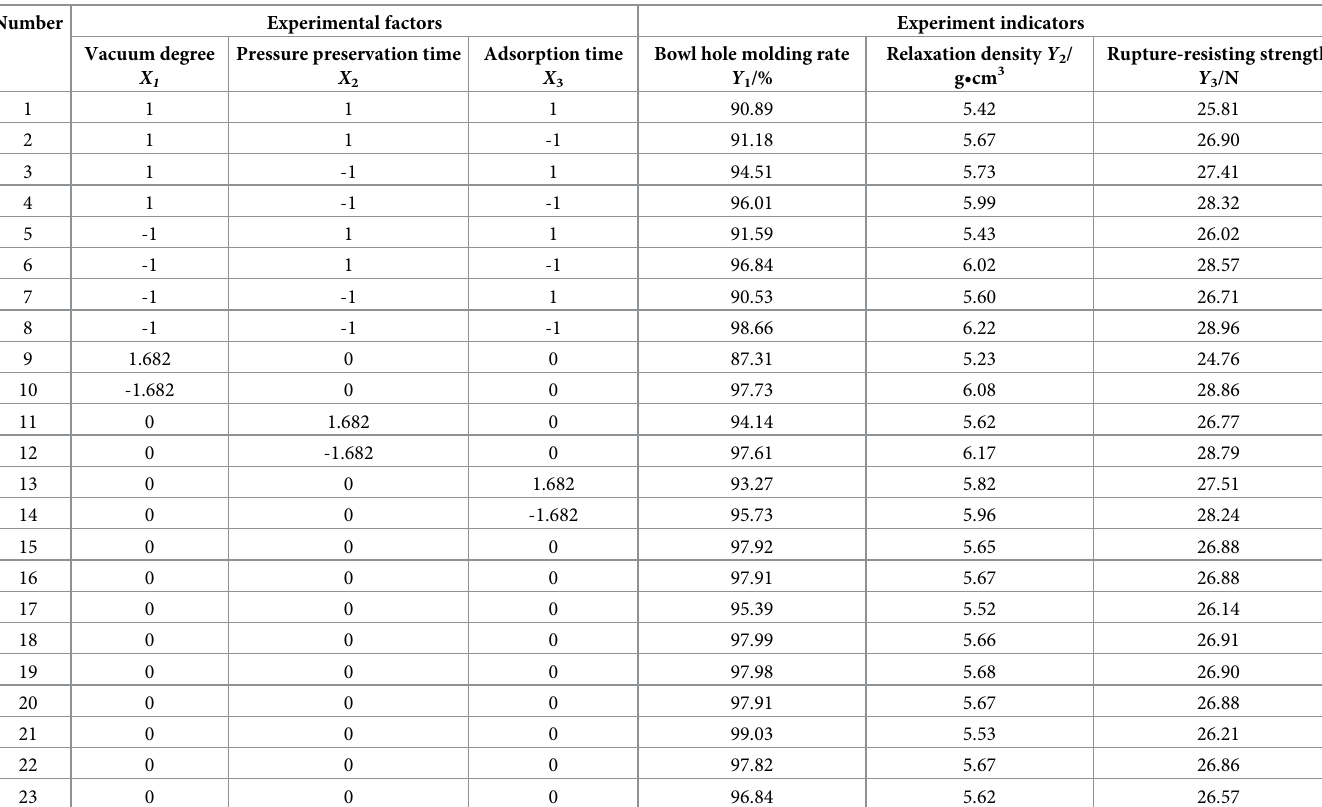
Table 3. Test protocols and